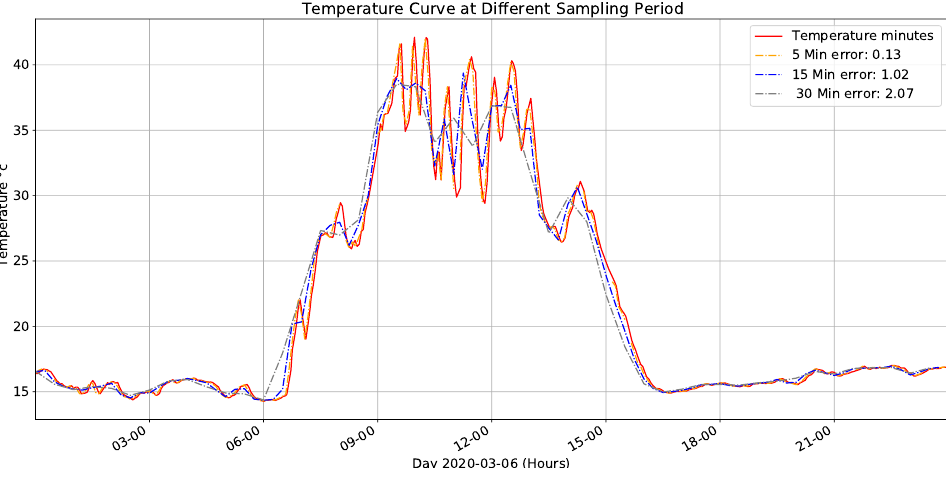
Figure 11. Temperature for different sampling